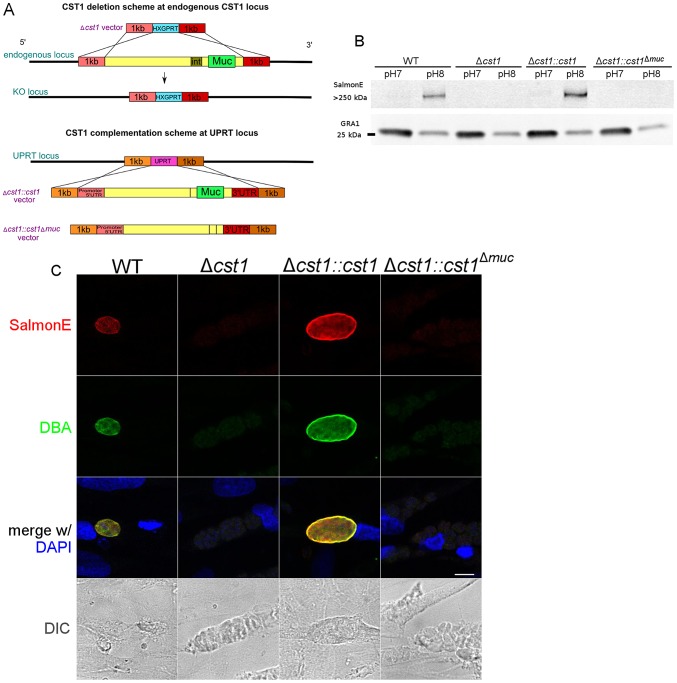
Characterization of CST1 knock out (Δcst1) and CST1 complemented T. gondii strains.(A) Schematic representation of disruption of CST1 and complementation of Δcst1 mutant. Upper half of the diagram represents the deletion of whole CST1 gene with Δcst1 vector. Lower half represents the complementation of CST1 genes at UPRT locus. (B) Immunoblot of T. gondii parasite cultures grown in normal and alkaline conditions probed with mAb SalmonE. SalmonE reactive antigen (CST1) is induced in alkaline conditions. Δcst1 knockout parasites are not recognized by mAb Salmon E, but reactivity is restored in full-length complement (Δcst1::cst1) but CST1Δmuc protein lacks the reactivity due to the loss of mucin-like domain. The parasite specific dense granule protein GRA1 is used as a loading control. (C) CST1 and DBA co-localize on in vitro cyst wall. HFF cells infected with WT, Δcst1, Δcst1::cst1, or Δcst1::cst1
Δmuc
 T. gondii strains under alkaline conditions were probed with SalmonE (red) or DBA lectin (green). Monoclonal antibody SalmonE and DBA staining co-localized. The presence of the full-length CST1 gene is necessary for mAb SalmonE and DBA staining on cyst wall. Bar, 10 µm.